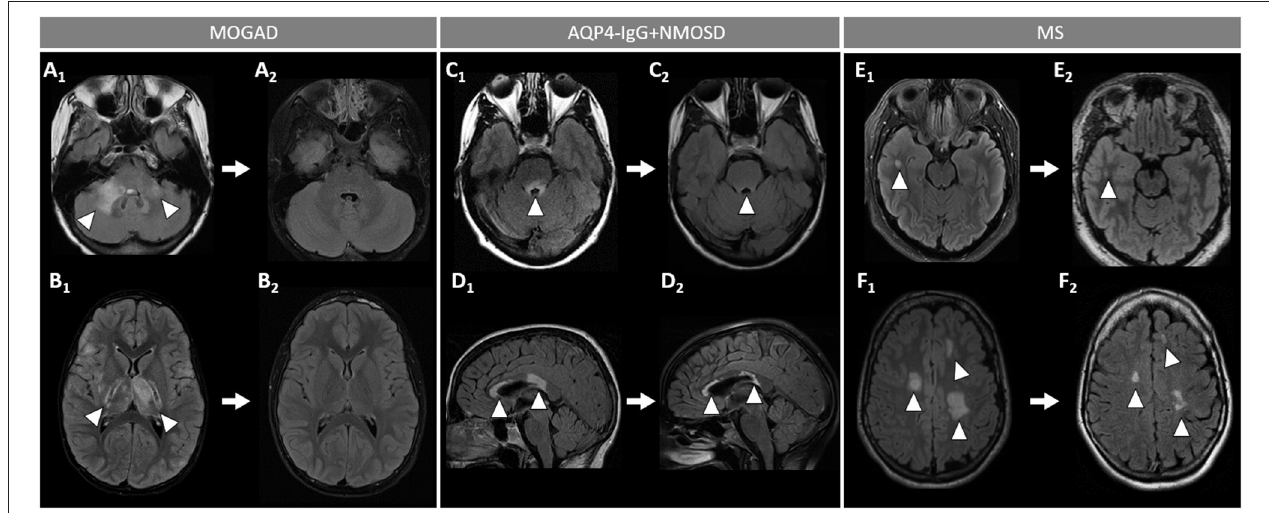
FIGURE 5 | Brain MRI lesion evolution in patients with MOGAD, AQP4-IgG + NMOSD, and MS on FLAIR images. [ (A,B) : MOGAD] Acute bilateral large T2-hyperintensities of middle cerebellar peduncles (right > left) (A 1 , arrowheads), and in the thalamus and cortico-spinal tract bilaterally (B 1 , arrowheads). All T2-lesions had resolved completely by the time of follow-up MRI (A 2 , B 2 ). [ (C D) : AQP4-IgG + NMOSD] Acute T2-hyperintense lesion around the 4th ventricle (C 1 , arrowhead), resolving to nearly undetectable at follow-up MRI (C 2 , arrowhead); and lesions involving the corpus callosum (D 1 , arrowheads), undergoing reduction in size without resolution on follow-up MRI (D 2 , arrowheads). [ (E,F) : MS] Acute T2-hyperintense white matter lesions (E 1 , F 1 , arrowheads), reduced in size but still visible on follow-up MRI (E 2 , F 2 , arrowheads). MOGAD, myelin oligodendrocyte glycoprotein antibody-associated disease; AQP4-IgG + NMOSD, aquaporin-4-IgG